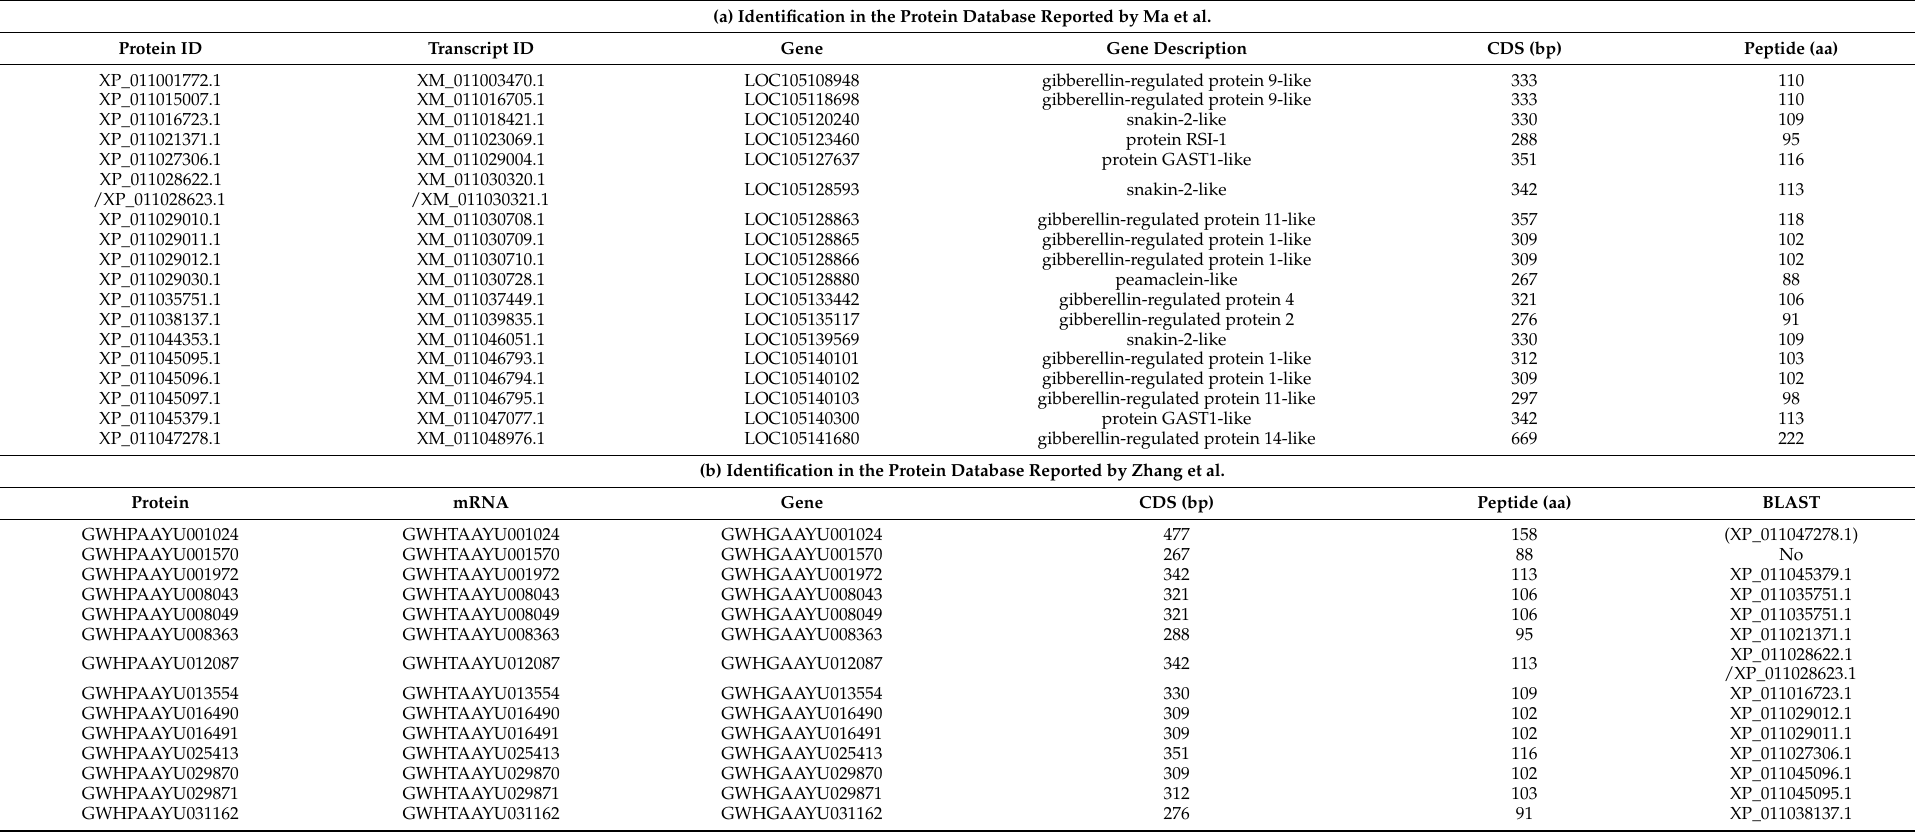
Table 1. Identification of GASA gene family in P. euphratica . (a) Identification in the Protein Database Reported by Ma et al.